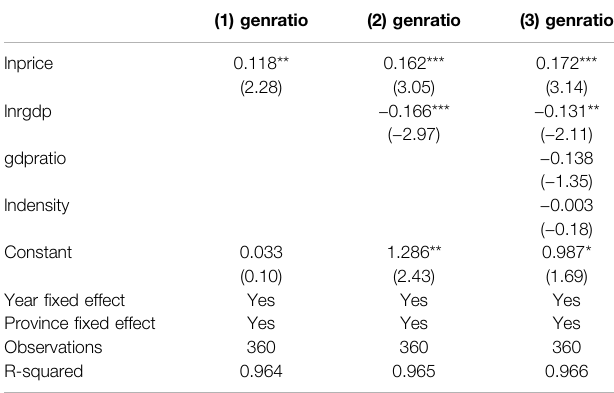
TABLE 2 | Fixed-effect